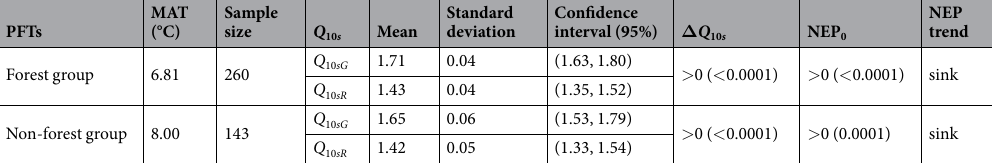
Table 2. Basic information, temperature sensitivity indexes of assimilation rate (GPP, Q 10 sG ) and respiration rate (RE,